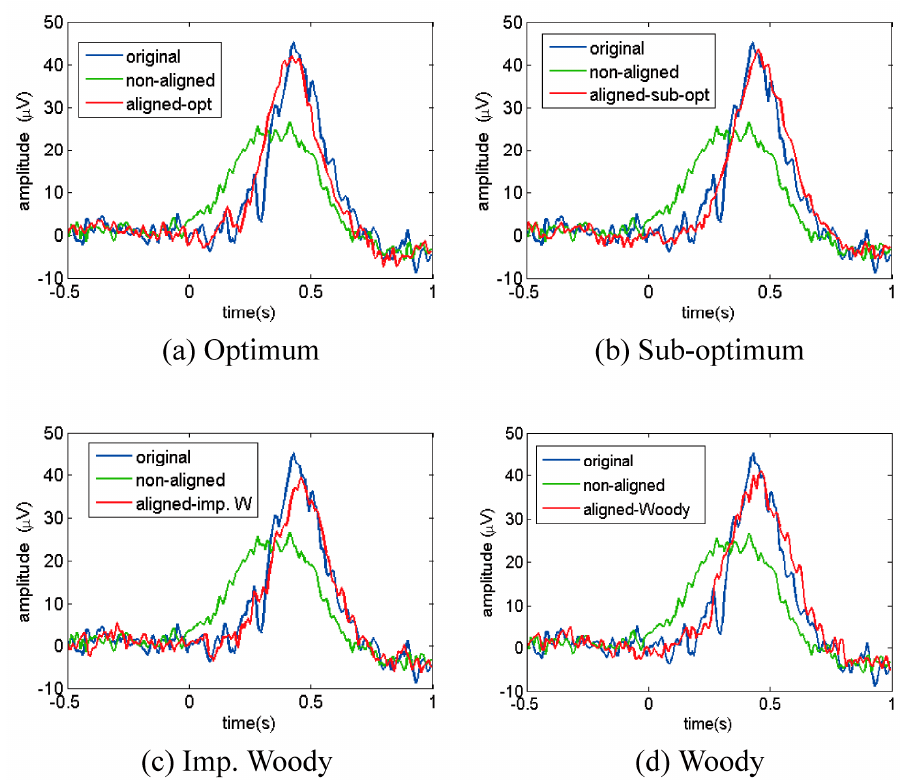
Figure 8. Averaged time domain ERP signal comparison between original ERP (blue dot line), ERP without realignment (green dot and dash line), and realigned signal by applying the ( a ) optimal; ( b ) sub-optimal; ( c ) improved Woody; and ( d ) Woody scheme (red solid line).